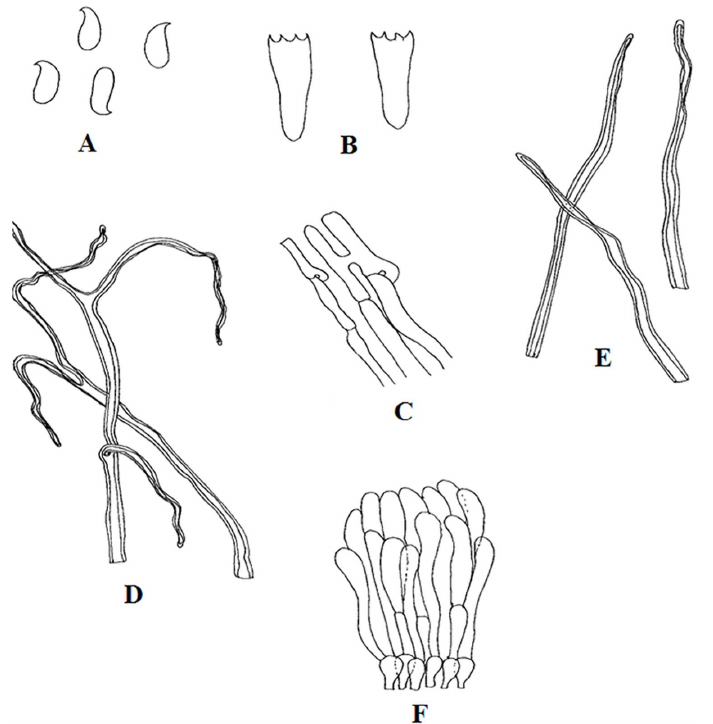
Fig 2. Lentinus sp.: A. Basidiospores, B. Basidia, C. Generative hyphae, D. Sketetalhyphae, E. Binding hyphae, F. Hyphal pegs.